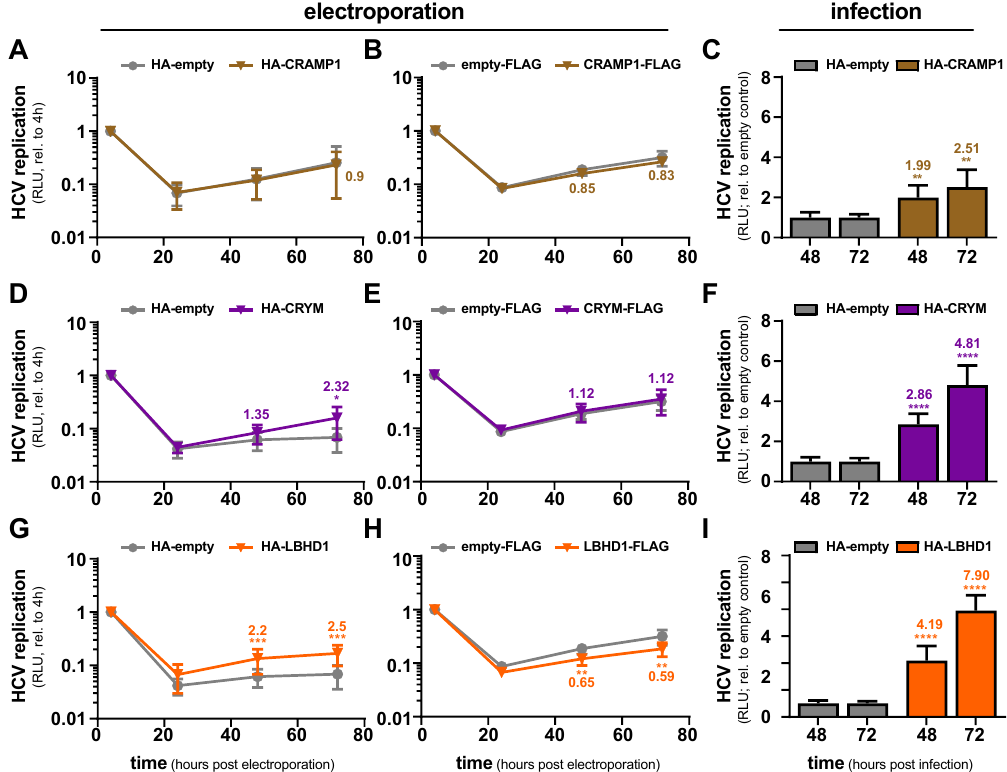
Figure 3. Overexpression of potential permissiveness determining factors in lowly permissive Huh7-LP cells. ( A , B ) Replication of a subgenomic HCV luciferase reporter replicon (gt1b) after electro-transfection into HA-CRYM ( A ) or CRYM-FLAG ( B ) overexpressing Huh7-LP cells compared to the respective empty vector control in a time-course of 72 h. ( C ) Expression levels of CRYM mRNA determined by qRT-PCR in CRYM-FLAG overexpressing Huh7-LP cells versus cells transduced with an empty-FLAG vector. ( D , E ) Replication of HCV in HA-LBHD1 ( D ) or LBHD1-FLAG ( E ) overexpressing Huh7-LP cells and ( F ) according expression levels of LBHD1. ( G , H ) Replication of HCV in HA-CRAMP1 ( G ) or CRAMP1-FLAG ( H ) overexpressing Huh7-LP cells and ( I ) according expression levels of CRAMP1. Luciferase data is normalized to the input signal four hours post electro-transfection and shows mean and standard deviation from at least three independent biological experiments. Significance was calculated using two-tailed, non-paired Student’s t test. * p ≤ 0.05, ** p ≤ 0.005, *** p ≤ 0.001, **** p ≤